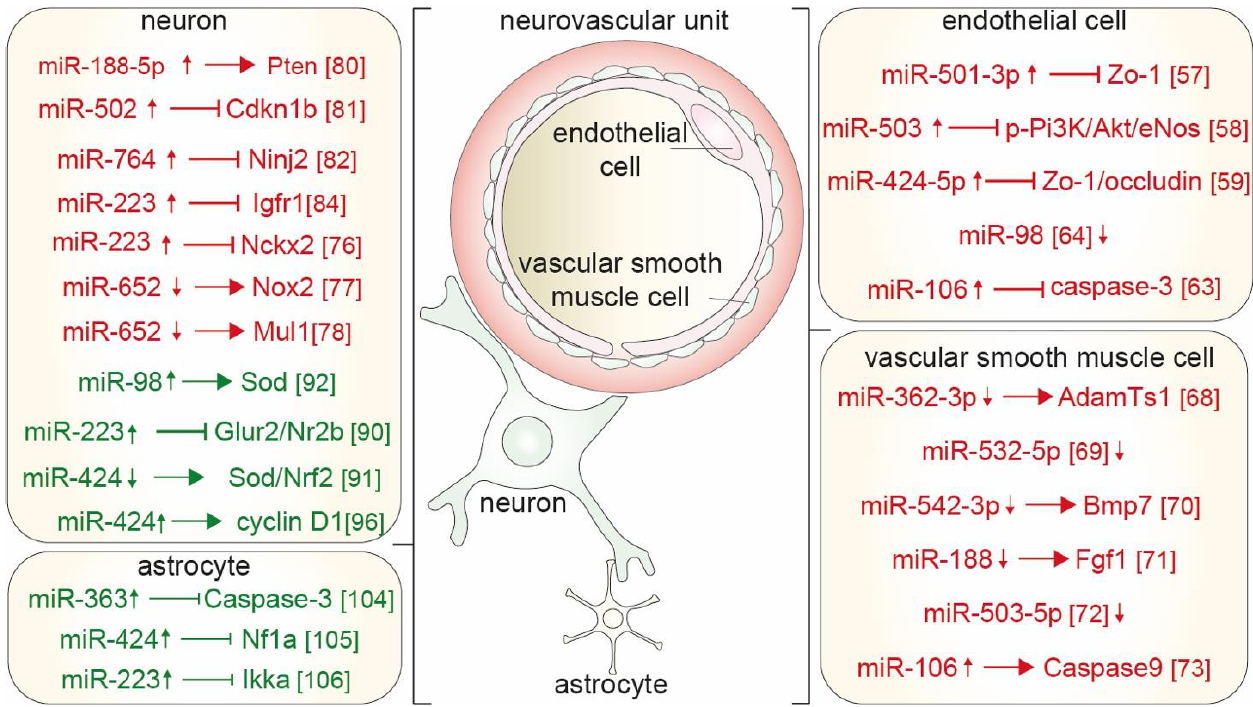
Figure 2. Overview of sex-specific miR expression in neurovascular units and target gene expression effect. Red font depicts stroke promoting mechanisms, while green font indicates stroke preventing mechanisms.